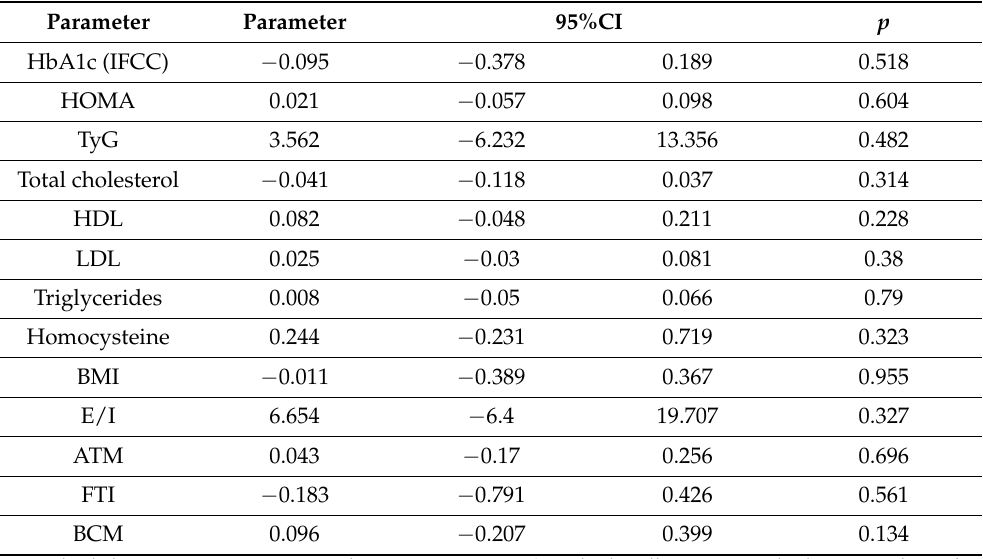
Table 6. Galectin-9 in serum after delivery.